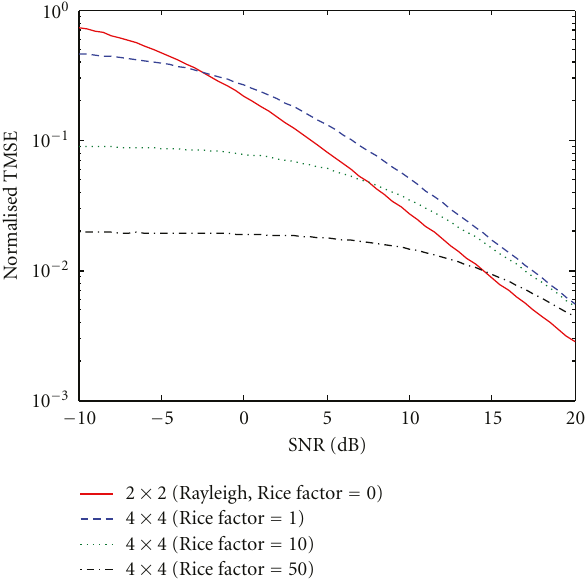
Figure 8: Normalized TMSEs of the SSLS estimator versus SNR in Rayleigh and Rician fading MIMO systems with L = 8, N P = 72 .